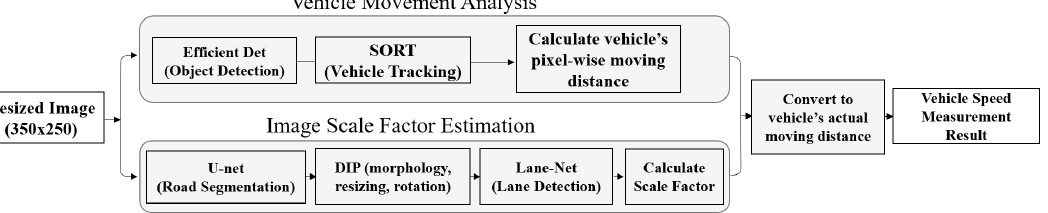
Figure 1. Overall flow of the proposed method.